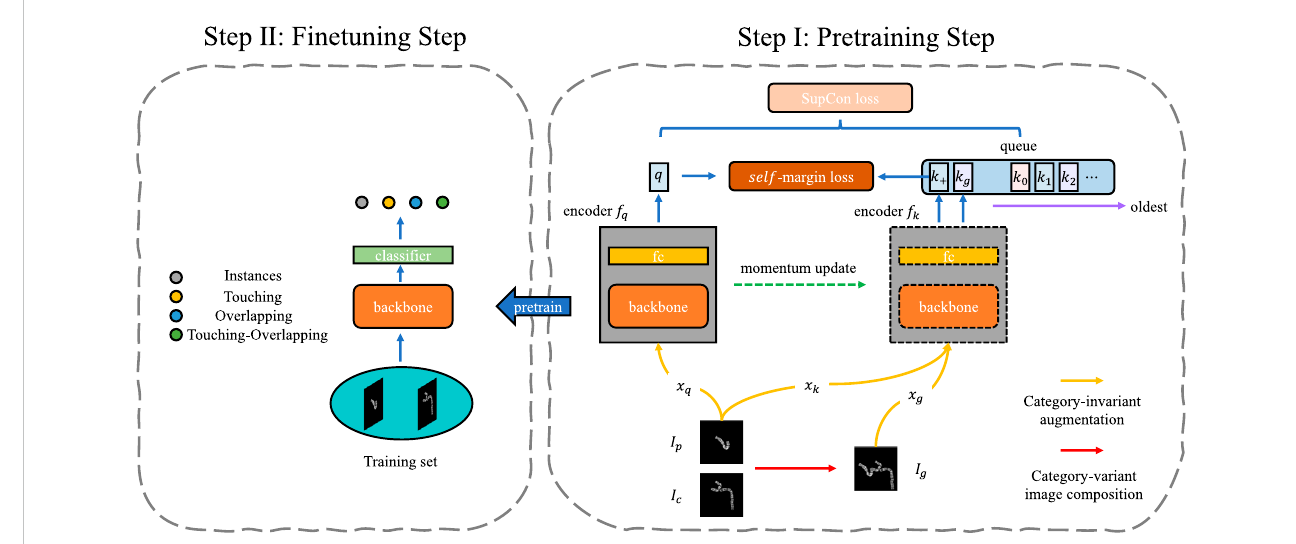
FIGURE 2 The framework of SupCAM. The pretraining step shown is based on MoCo [He et al. (2020)] structure but imports two modi fi cations, namely category- variant image composition and self -margin loss. The fi ne-tuning step will initialize the backbone using weights pre-trained in the fi rst step and fi nally reports identi fi cation